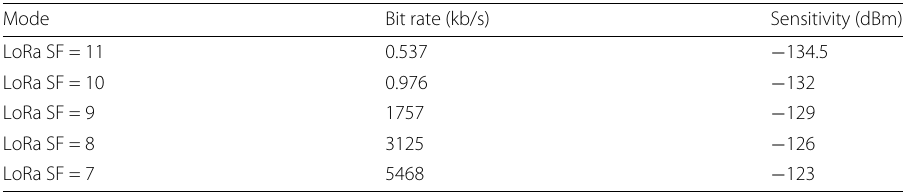
Table 1 Bit rate and sensitivity according to LoRa